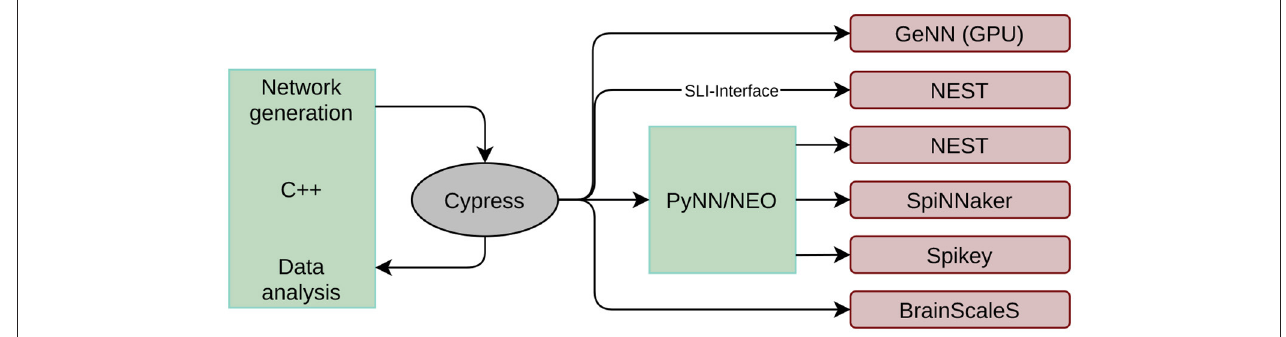
FIGURE 1 | Structure of the Cypress library. Network generations and data analysis is done in C++ code. The library takes care of mapping the created network to the target platforms listed on the right side using the individual platform